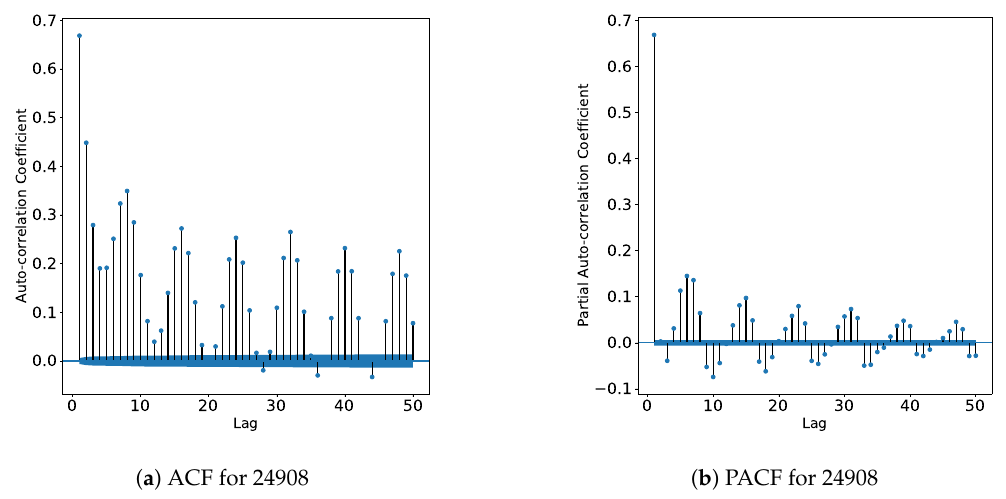
Figure 6. Auto-Correlation Function (ACF) and partial ACF (PACF) for